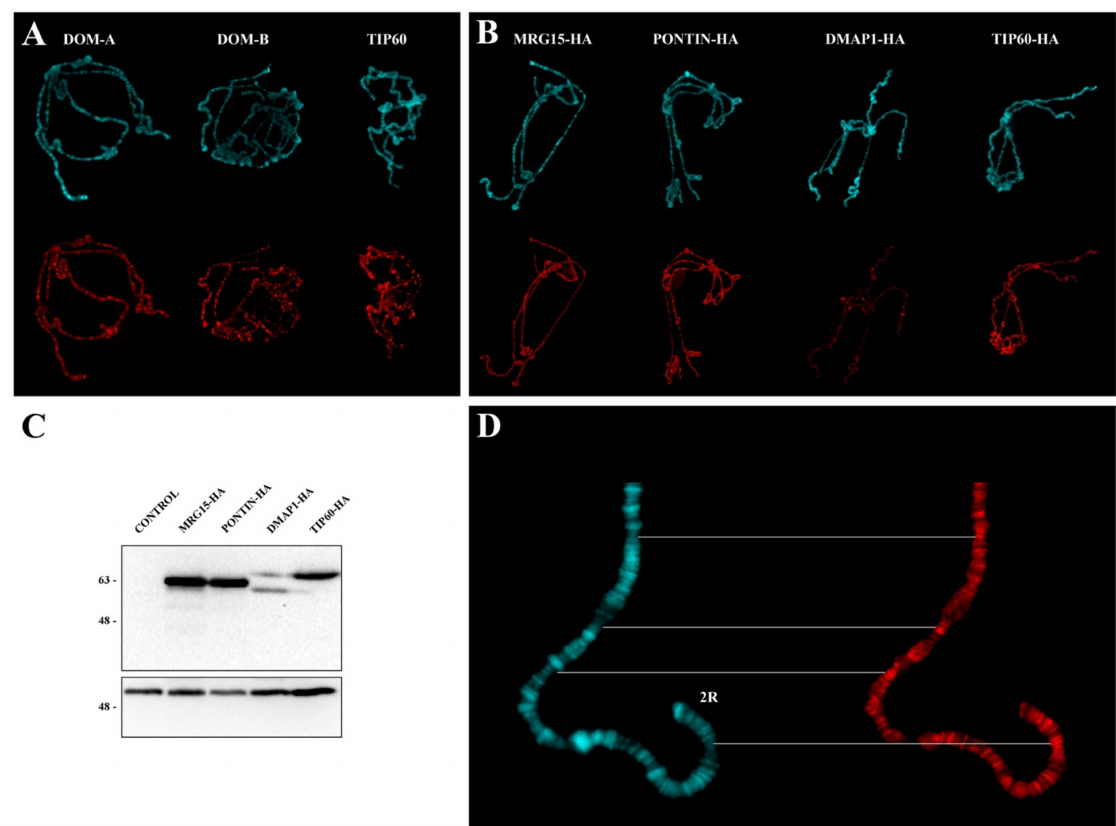
Figure 2. Polytene chromosome distribution of endogenous and HA-fused subunits. ( A ) Distribution of endogenous DOM-A, DOM-B and TIP60. DAPI staining (blue), immunostaining (red). ( B ) Distribution of MRG15, PONTIN, DMAP1, and TIP60 HA-fusion proteins. ( C ) Western blotting on protein extracts from third instar larvae showing the expression of HA-fusion proteins following activation. No expression was detected in not activated controls. Numbers indicate the molecular weight in kD. ( D ) Example of PONTIN-HA distribution along the distal portion of chromosome 2R: The signals tend to be located at the interbands. DAPI staining (blue), immunostaining (red).